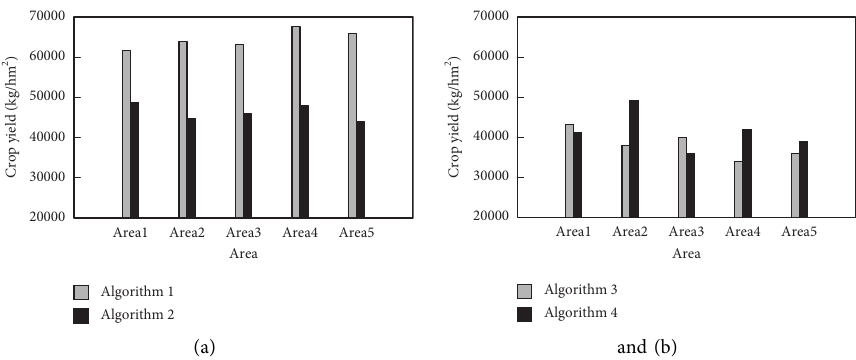
Figure 5: Crop yield of different algorithms. (a) Crop yield of algorithm-1 and algorithm-2 and (b) crop yield of algorithm-3 and